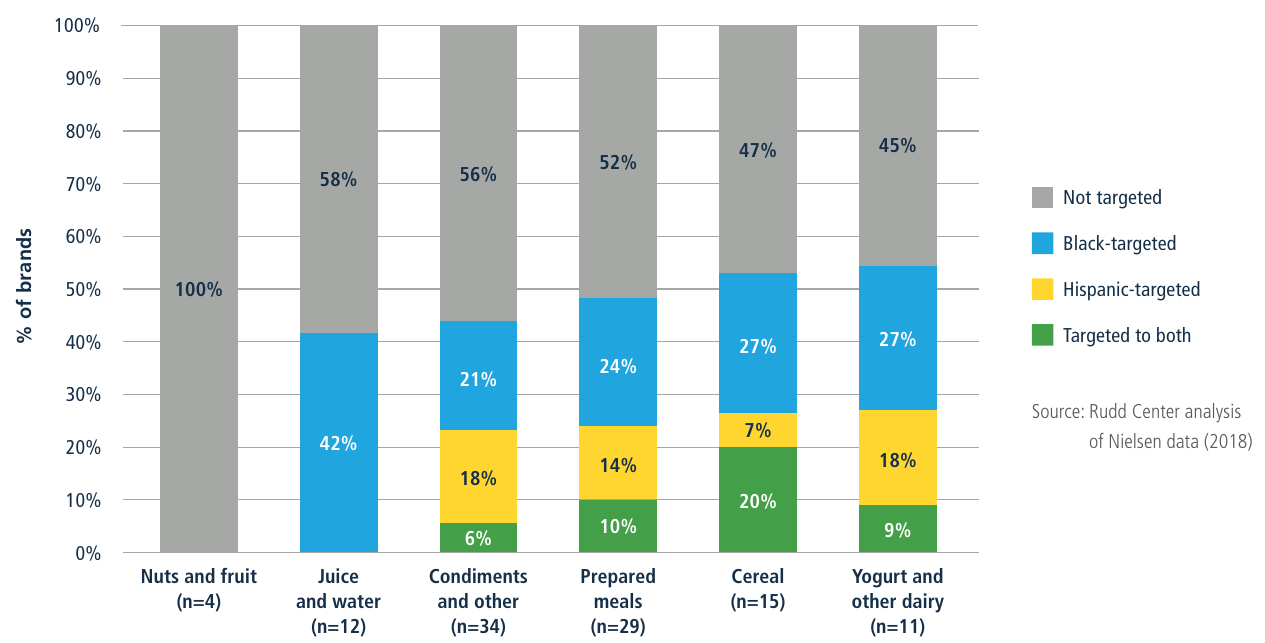
FIGURE 14. CATEGORIES LESS LIKELY TO TARGET TO HISPANIC AND BLACK